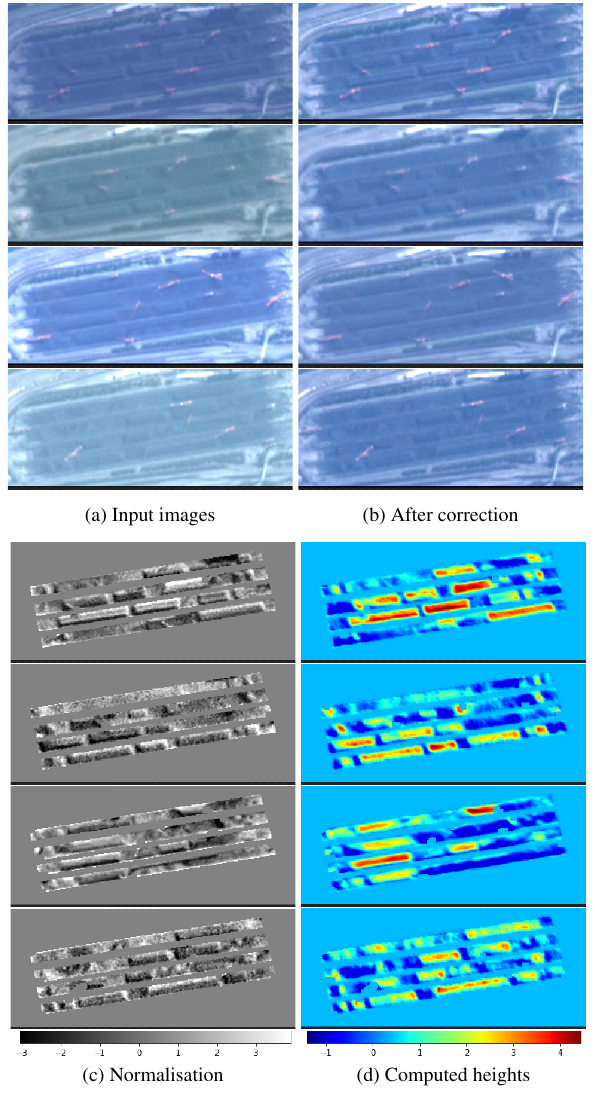
Figure 5. Input images before and after relative radiometric correction (Hessel et al., 2020) , normalised images and predicted heights from our shape-from-shading method for the second site, more challenging because smaller ( 1 . 17 × 0 . 46